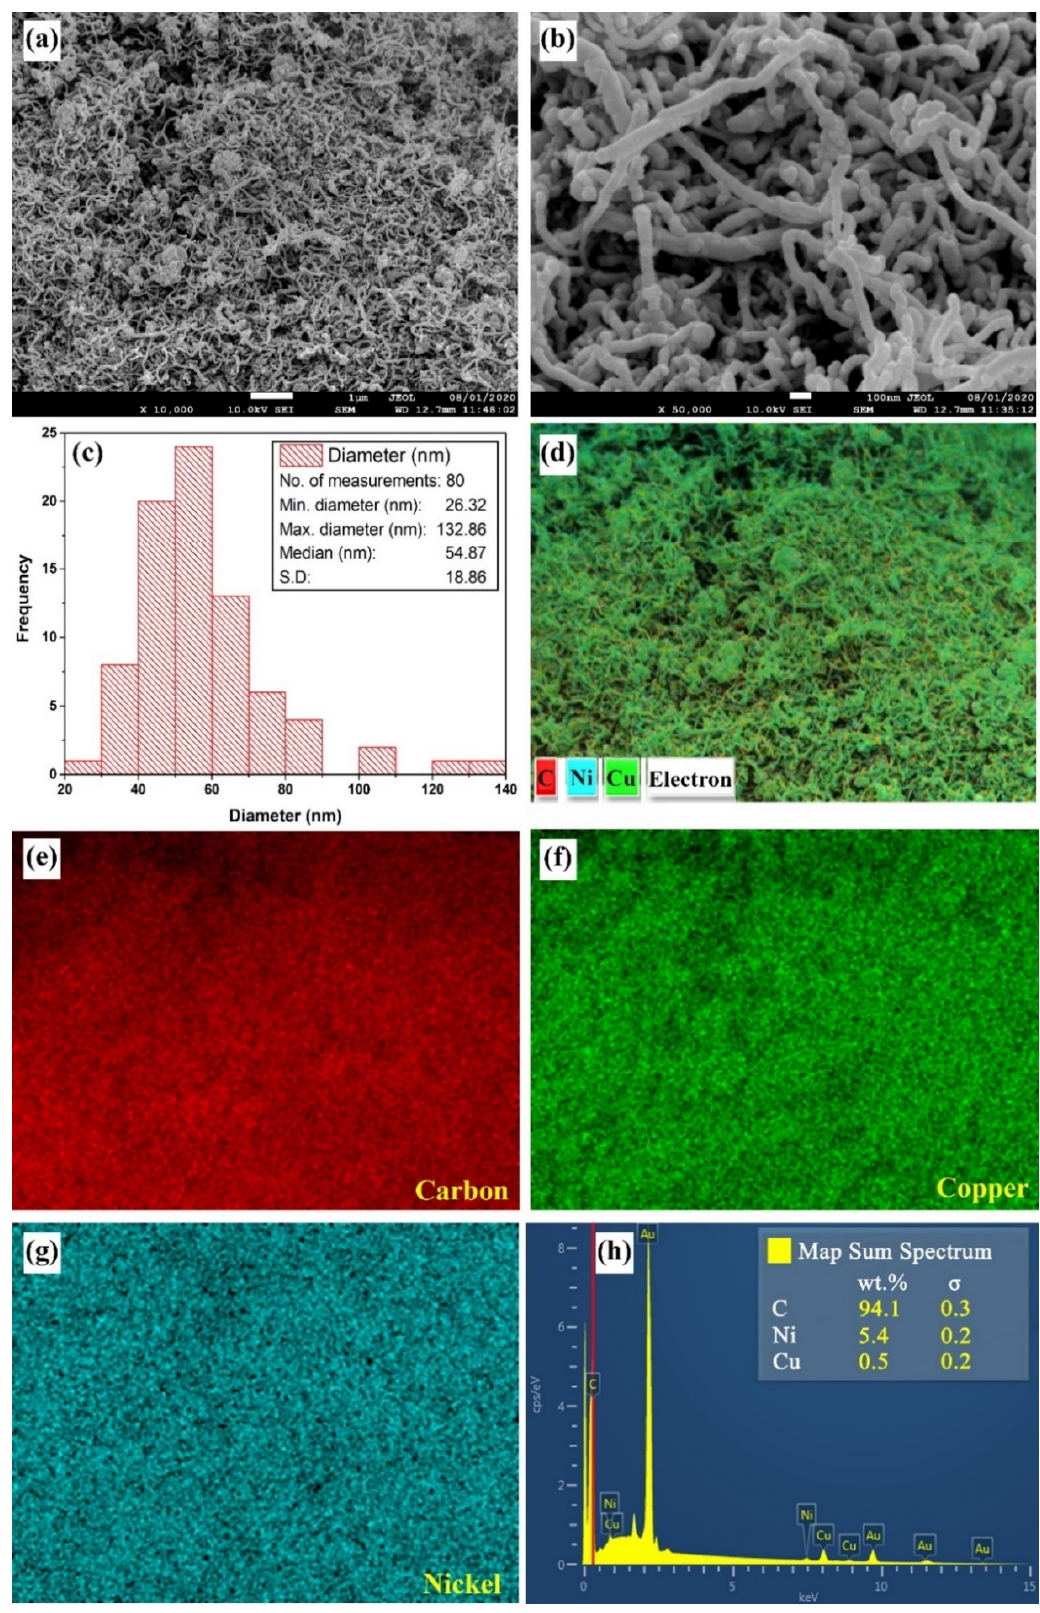
Figure 4. FE-SEM and EDS characterization, where ( a – b ) shows the particles morphology at low and high magnifications, ( c ) illustrates the diameter distribution, ( d – g ) demonstrates the elemental mapping, and ( h ) shows the x-ray spectrum.